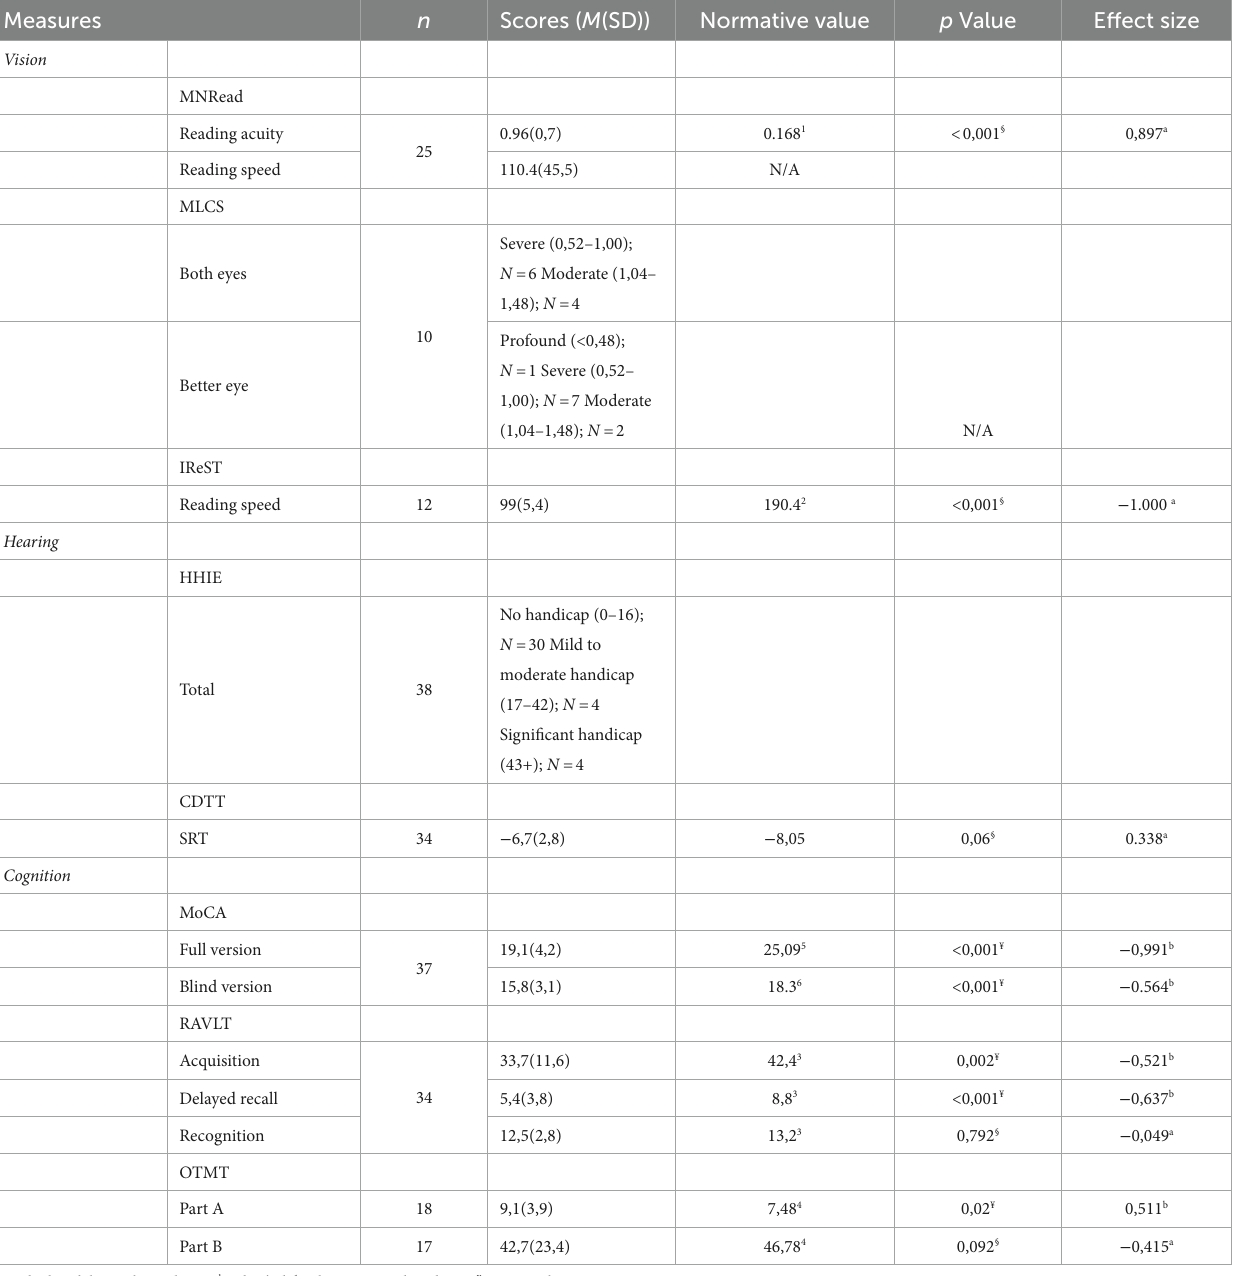
TABLE 2 Comparison of measures to normative values. Measures n Scores ( M (SD)) Normative value p Value Effect